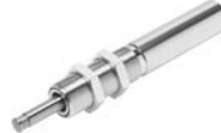
Fig. 1. Hydraulic damper [1]